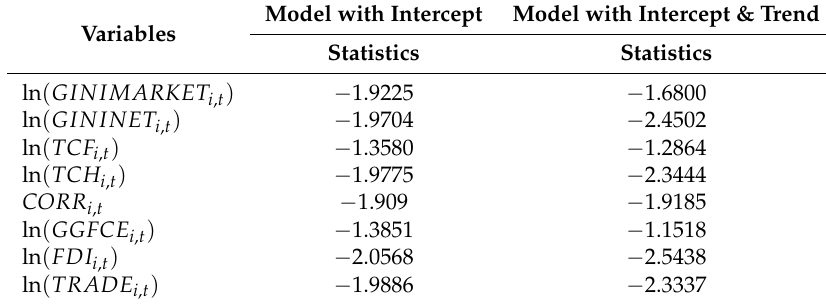
Table 3. Cross-sectionally augmented Im-Pesaran-Shin (CIPS) Panel Unit Root Test Results. Model with Intercept Model with Intercept & Trend Variables Statistics Statistics